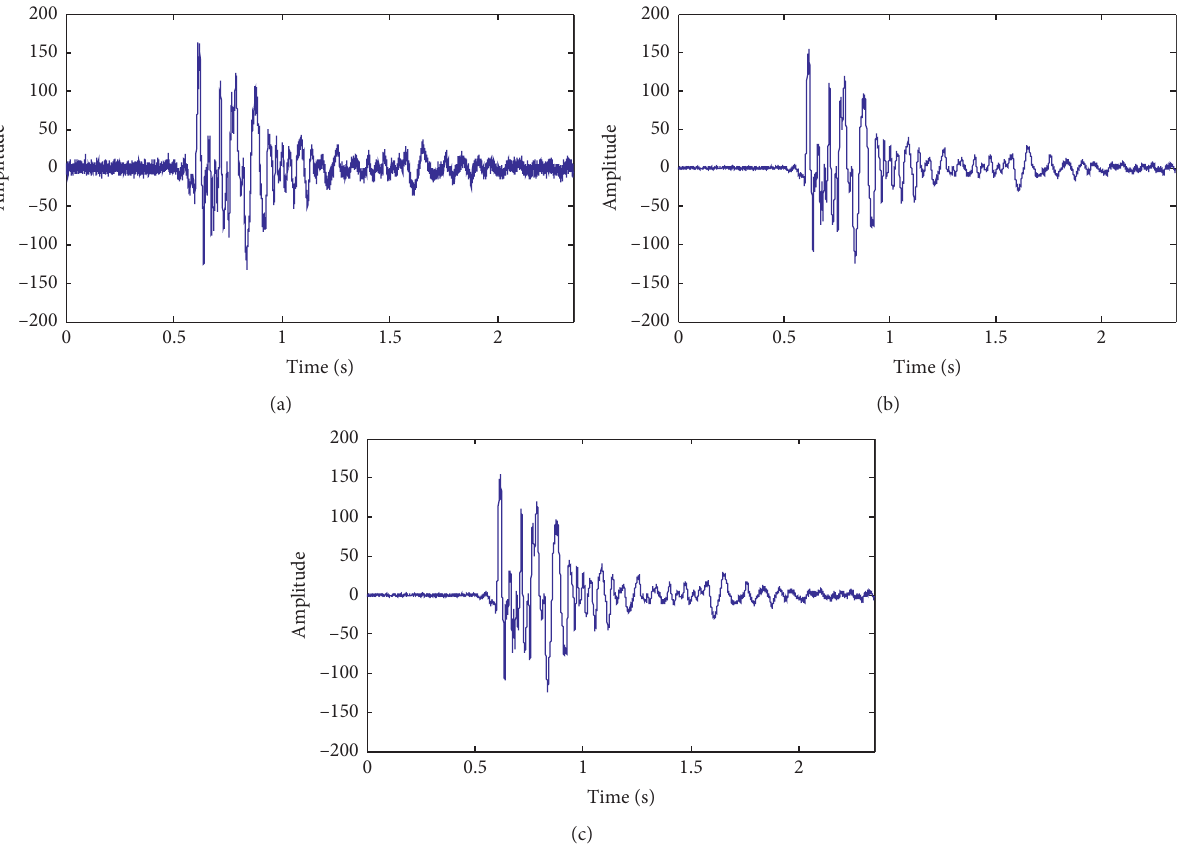
Figure 18: Diagram of different modes of signal processing. (a) Original input signal diagram. (b) Signals after on-chip preprocessing. (c) Signals after processing by the upper computer.